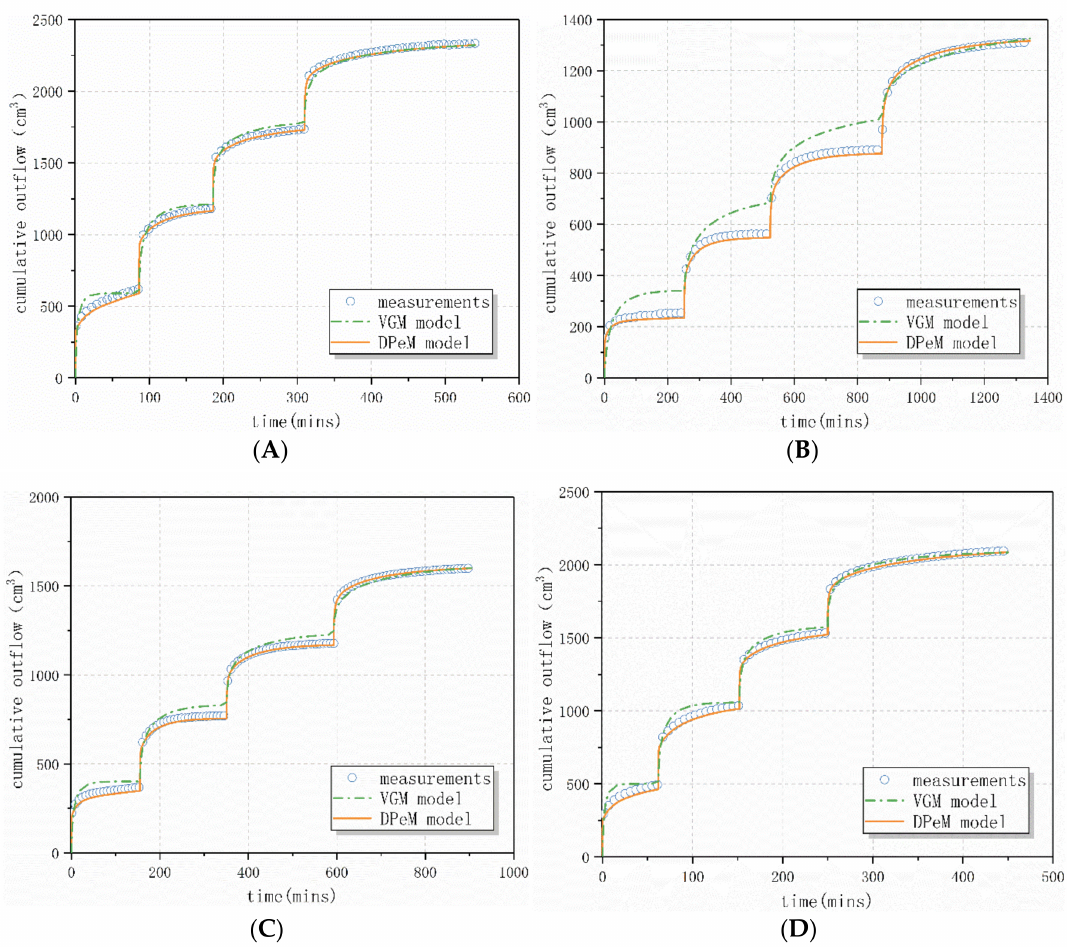
Figure 4. Cumulative outflow data for groups ( A – D ) during drainage experiments with inverse modeling fits using best-fit parameters.